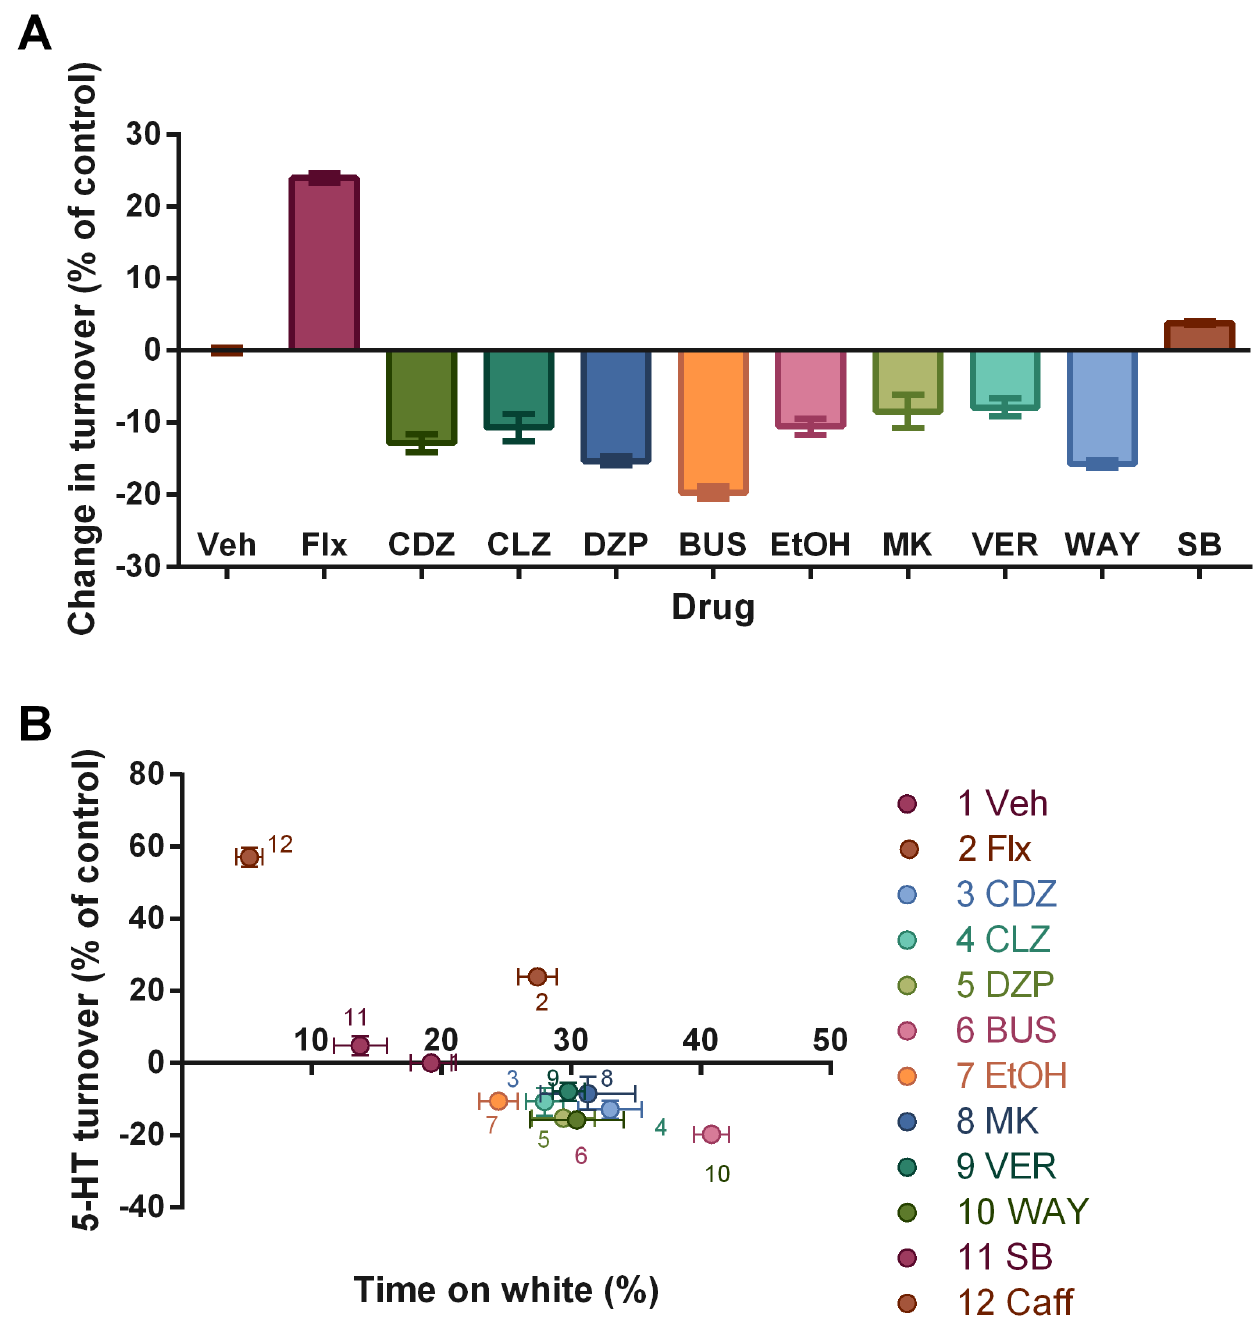
Figure 4. Drugs which cluster on the ’anxiolytic’ group decrease 5-HT turnover in the brain. (A) Turnover rates, as measured by 5-HIAA:5- HT ratios, normalized to the values of vehicle-treated animals, for the following drugs: fluoxetine (FLX; chronic treatment with 10 mg/kg); chlordiazepoxide (CDZ; 0.02 mg/kg); clonazepam (CLZ; 0.05 mg/kg); diazepam (DZP; 1.25 mg/kg); buspirone (BUS; 50 mg/kg); ethanol (EtOH, 2.5%); dizocilpine (MK; 0.005 mg/kg); verapamil (VER; 5 mg/kg); WAY 100,635 (WAY; 0.03 mg/kg); and SB 224,289 (SB; 2.5 mg/kg). Asterisks mark statistically significant differences in relation to vehicle-treated animals (F 10, 43 =45.99, p , 0.0001, one-way ANOVA followed by Dunnett’s Multiple Comparison test). Bars represent mean (B) Correlation between turnover rates ( Y -axis) and time spent in the white compartment ( X -axis) for vehicle- and drug- treated animals ( n =4 for each point). Points represent means and error bars represent standard errors. A negative correlation is found between the decrease in serotonin turnover and the increase in time on white produced by a drug (r 2 =0.5688, p=0.0073). doi:10.1371/journal.pone.0103943.g004 temperature (28 u C) and a pH of 7.0–8.0. Lighting was provided by Drugs fluorescent lamps in a cycle of 14–10 hours (LD), according to the Anhydrous caffeine was bought from Quimis (Diadema/SP, standards of zebrafish care [64]. Brazil). PACPX, DPCPX, ZM 241385 and DMPX were bought from Research Biochemicals International (Natick/MA, USA).